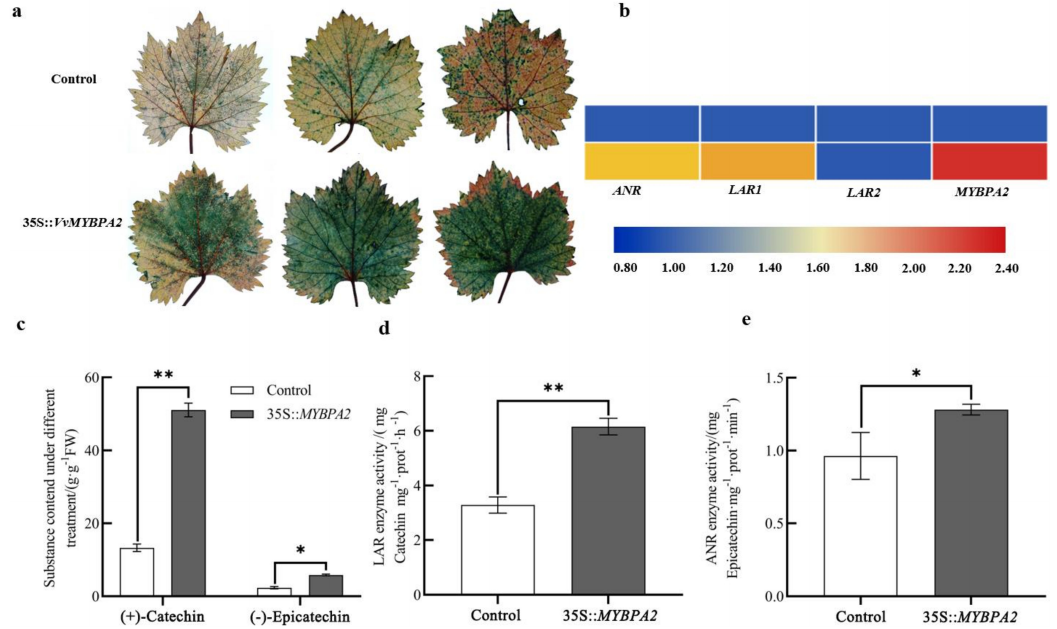
Figure 2. Effect of transient overexpression of VvMYBPA2 in grape leaves. ( a ) DMACA staining results under different treatments. ( b ) Effects of different treatments on gene expression related to proanthocyanidin biosynthesis. ( c ) Effects of different treatments on catechin and epicatechin content. ( d , e ) Effects of different treatments on activities of LAR and ANR enzymes. Note: ** indicates extremely significant differences at the level of p < 0.01; * indicates significant differences at the level of p < 0.05, while ns indicates no significant difference.